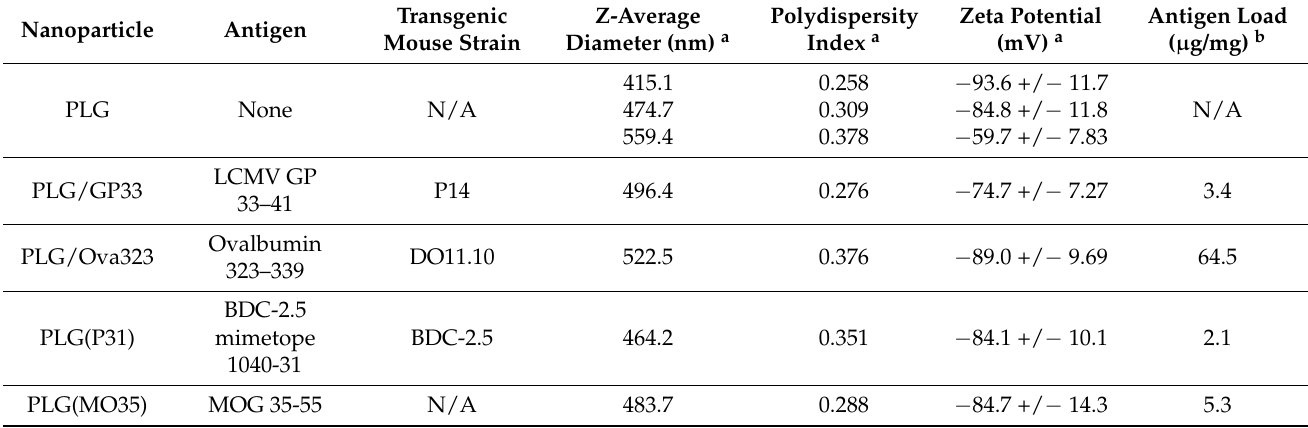
Table 1. Properties of all nanoparticles used in this